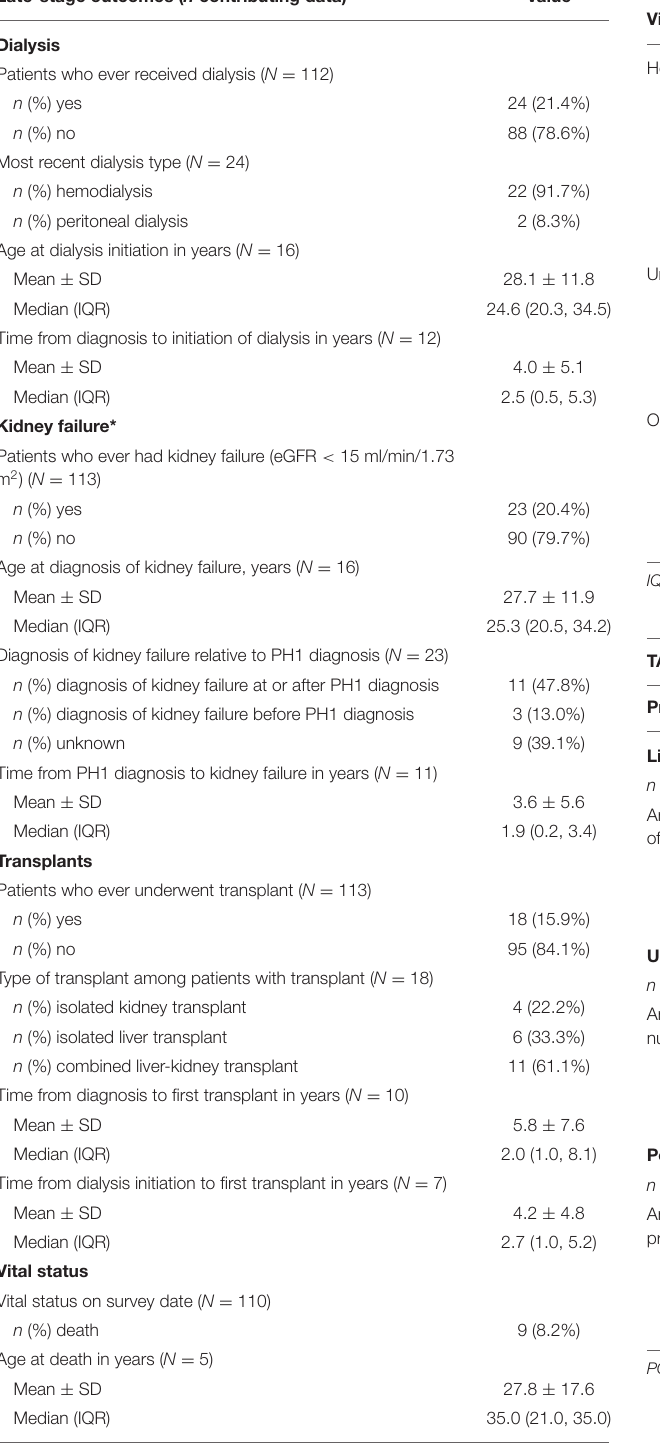
TABLE 3 | Late-stage outcomes of PH1. TABLE 4 | PH1-related hospitalizations, urgent/emergency care visits, and outpatient visits during follow-up.